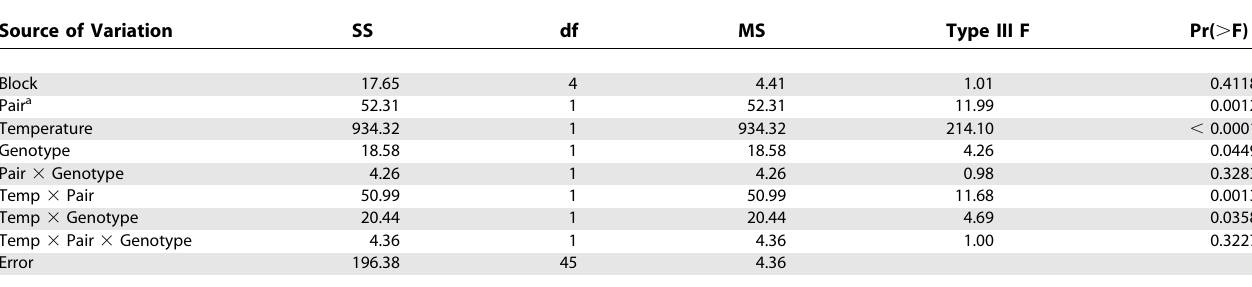
Table 3. ANOVA Describing the Effect of Gene H Mutation A47V in Natural Phage Isolates Source of